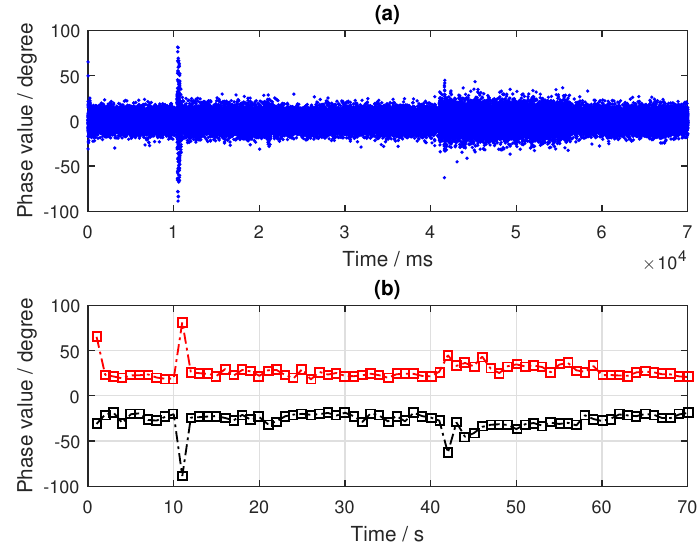
Figure 12. Results of the BeiDou IGSO satellite (PRN16) reflected signal: ( a ) Phase difference information (in ms); ( b ) Phase difference information (in